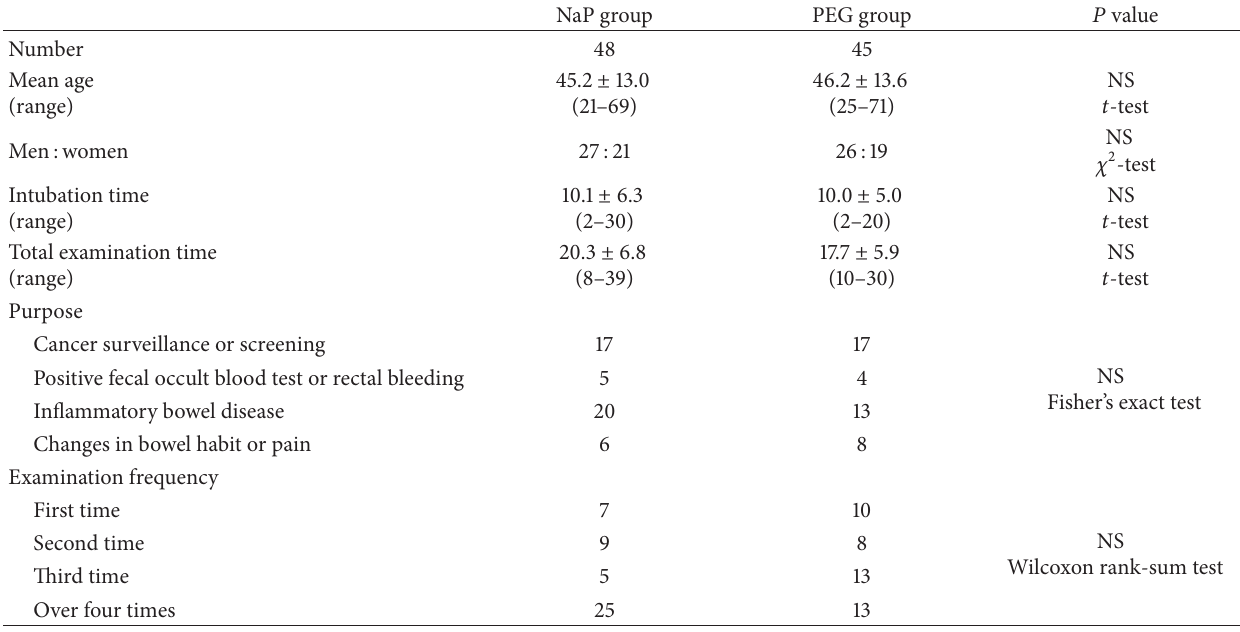
Table 1: Patients’ demographic features and indications for surveillance